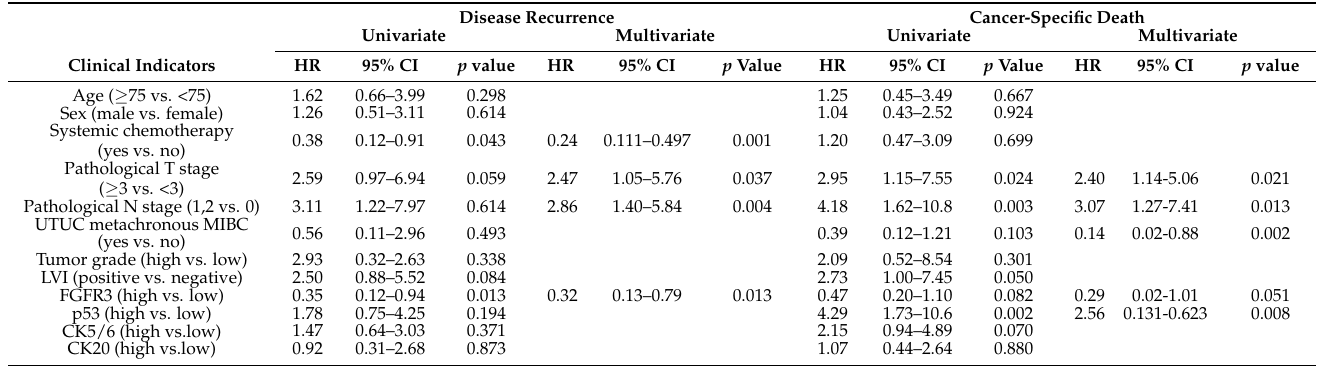
Table 6. Uni- and multivariate analyses evaluating the prognostic factors associated with oncological outcomes in MIBC patients ( n = 70). Abbreviations: MIBC; muscle-invasive bladder cancer, HR; hazard ratio, CI; confidence interval, UTUC; upper tract urothelial carcinoma, LVI; lymphovascular invasion, FGFR; fibroblast growth factor receptor, CK;